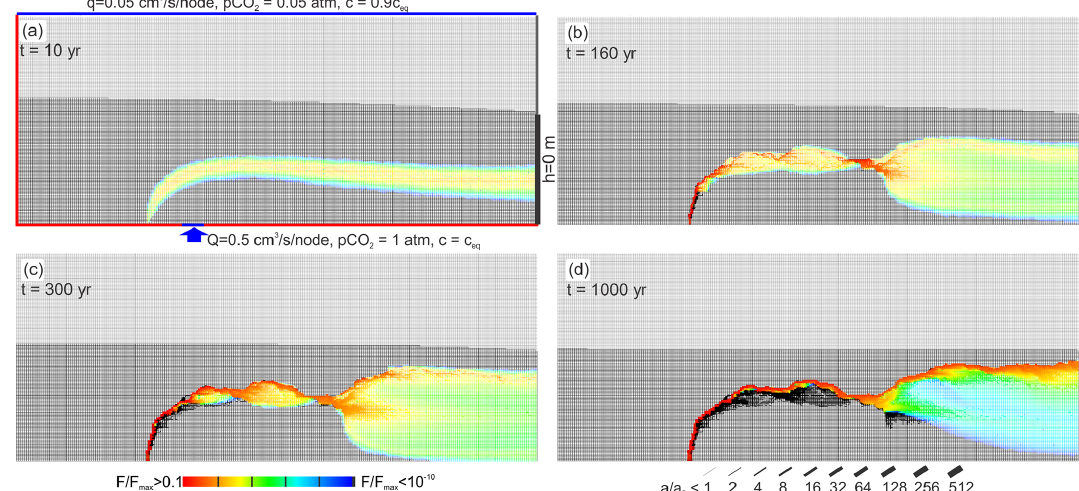
Figure 18. Change in boundary conditions on the outflow to constant head